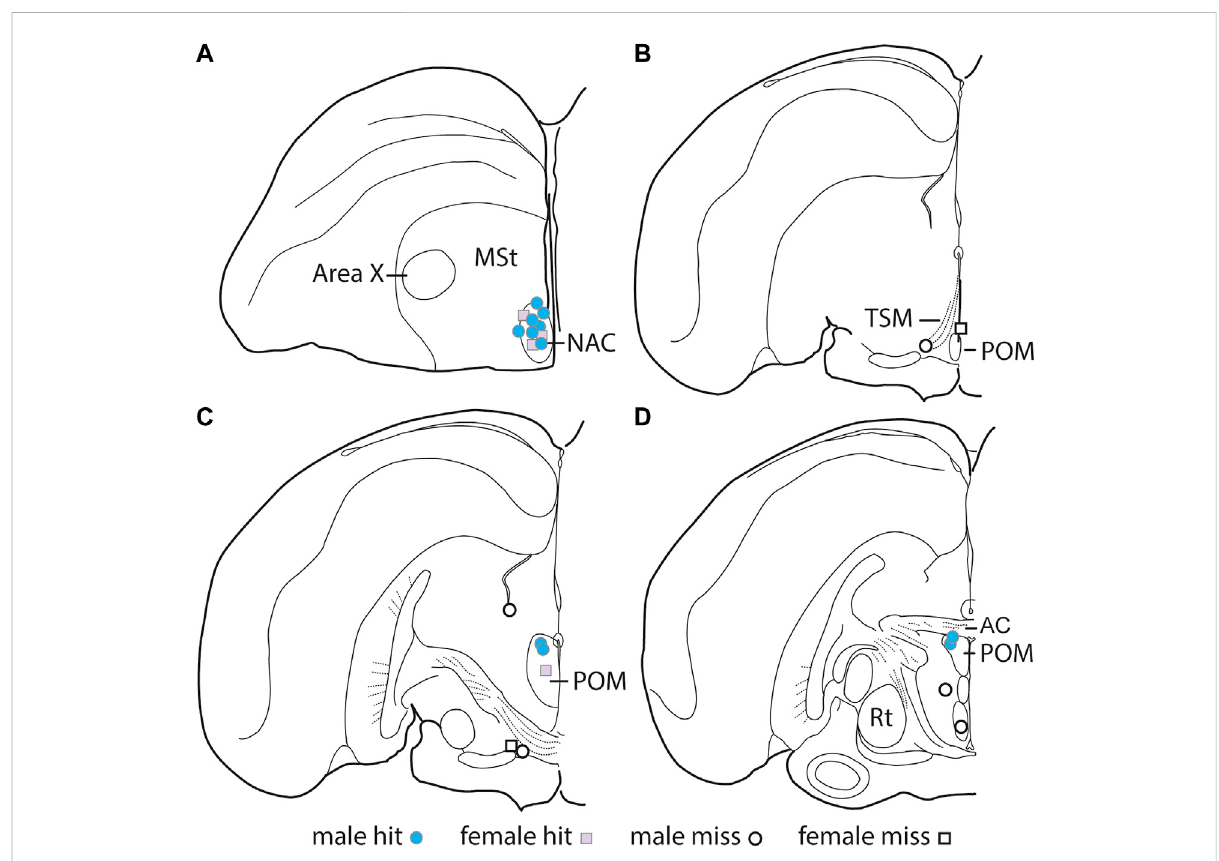
FIGURE 2 Location of DAMGO infusion sites. Illustration of one hemisphere of starling brain, with hits represented by fi lled-in shapes and misses represented by open shapes. Males are represented by circles, and females are represented by squares. AC, Anterior commissure; MSt, medial striatum; Rt, nucleus rotundus; TSM, tractus